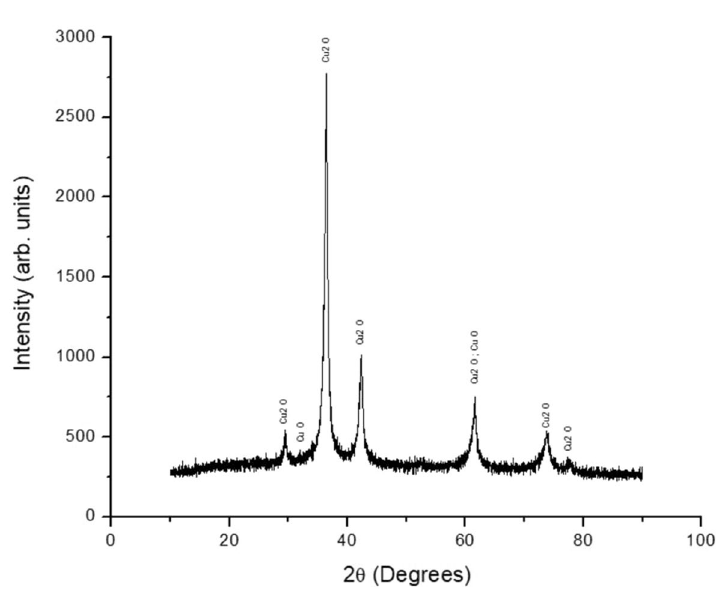
Figure 3. XRD analysis of the CuNPs/paint spray materials. There are two identified phases of copper oxide, cuprous oxide (Cu 2 O) and cupric oxide (CuO). The phase with the highest intensity and peak was Cu 2 O, which means that it is the most dominant phase on the synthesized coating. The peaks appear at multiple 2 theta degrees: 29.53°, 36.40°, 42.36°, 61.57°, 73.80°, and 77.67°. Some CuO phases were also detected at 2 theta 32.01° and